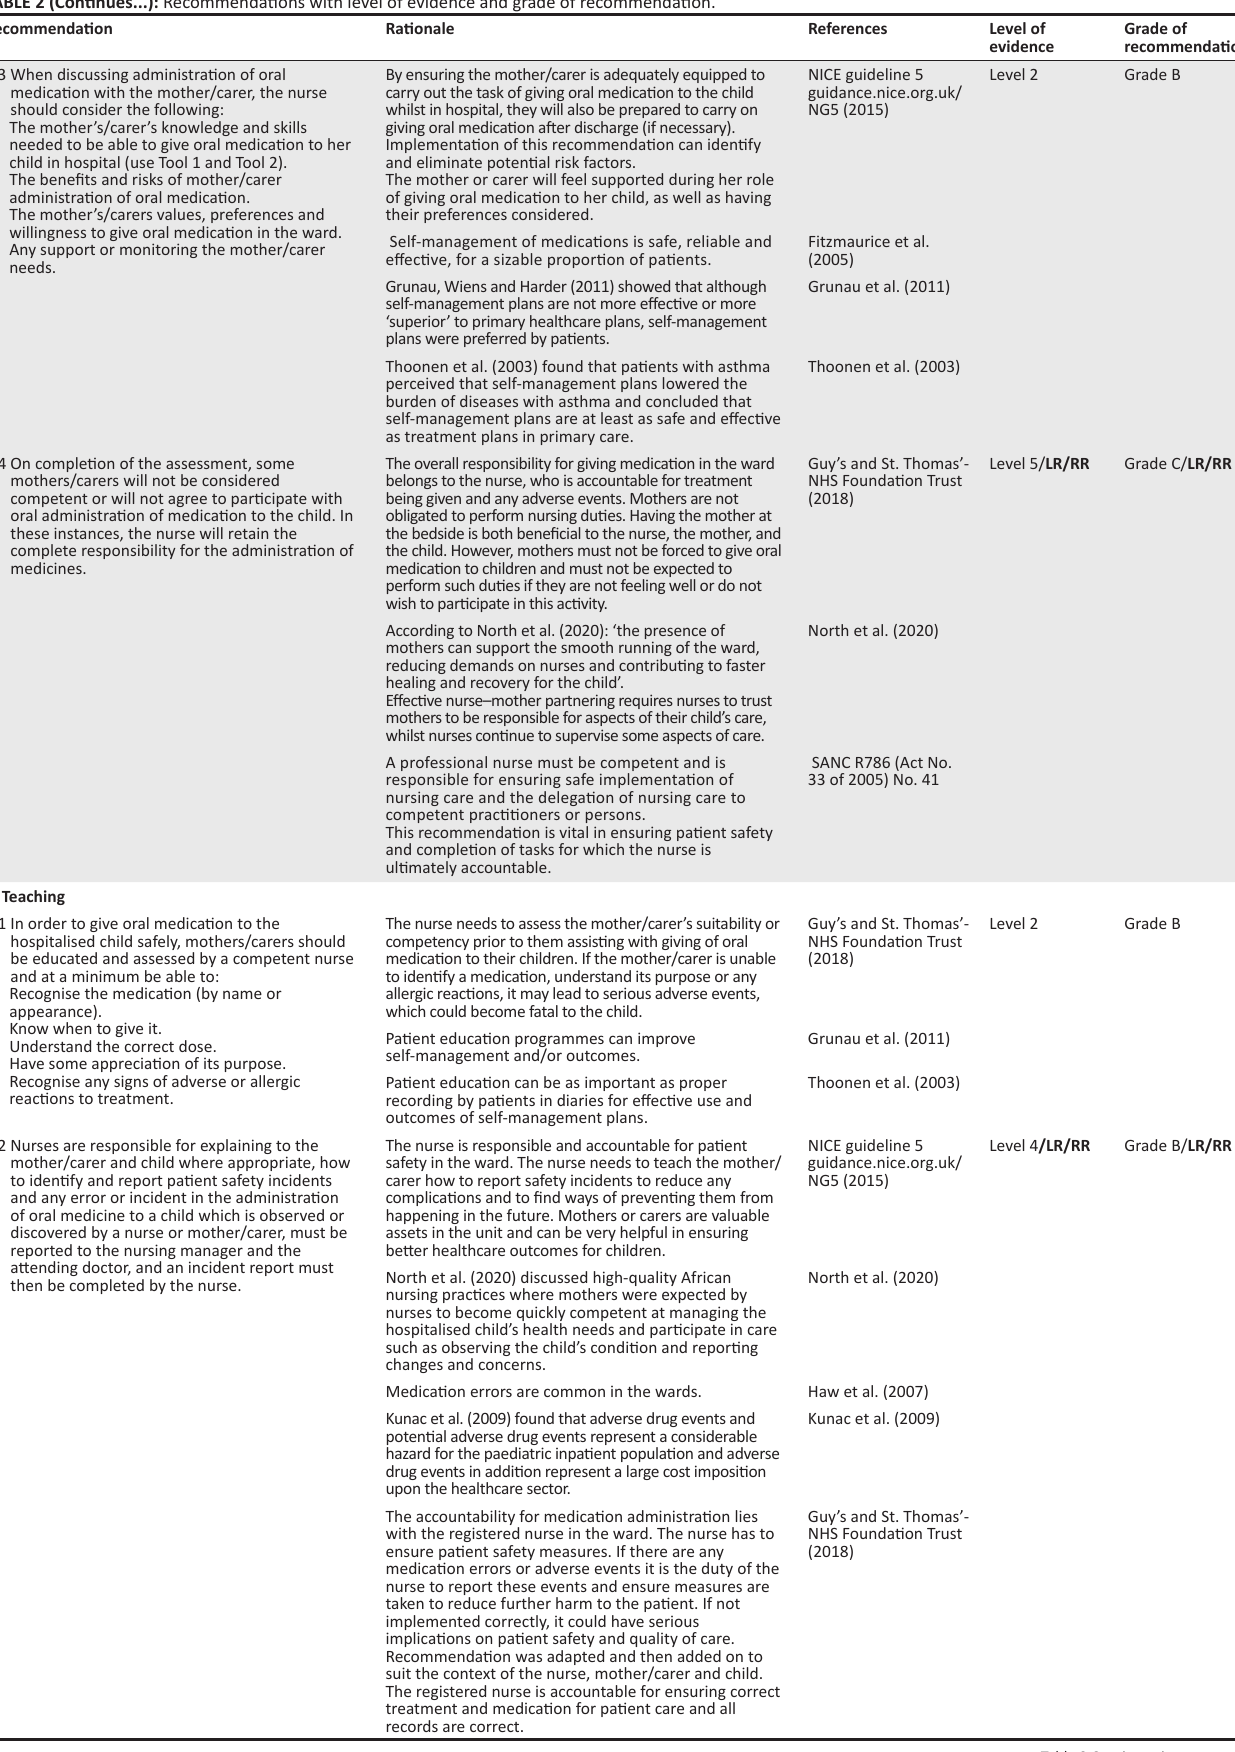
TABLE 2 (Continues...): Recommendations with level of evidence and grade of